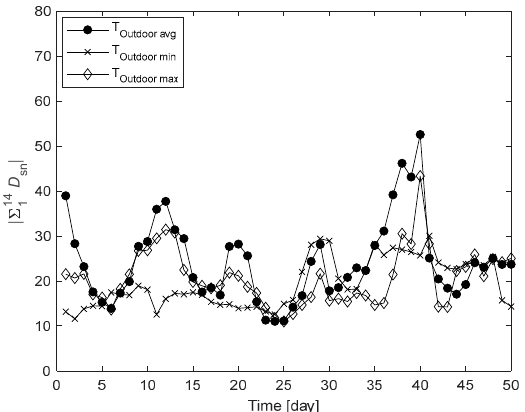
Figure 5. Variation of the classification potential ( D sn values) with daily minimum, maximum and average outdoor temperatures. Day 1 on the x -axis is the first day of the growing season.